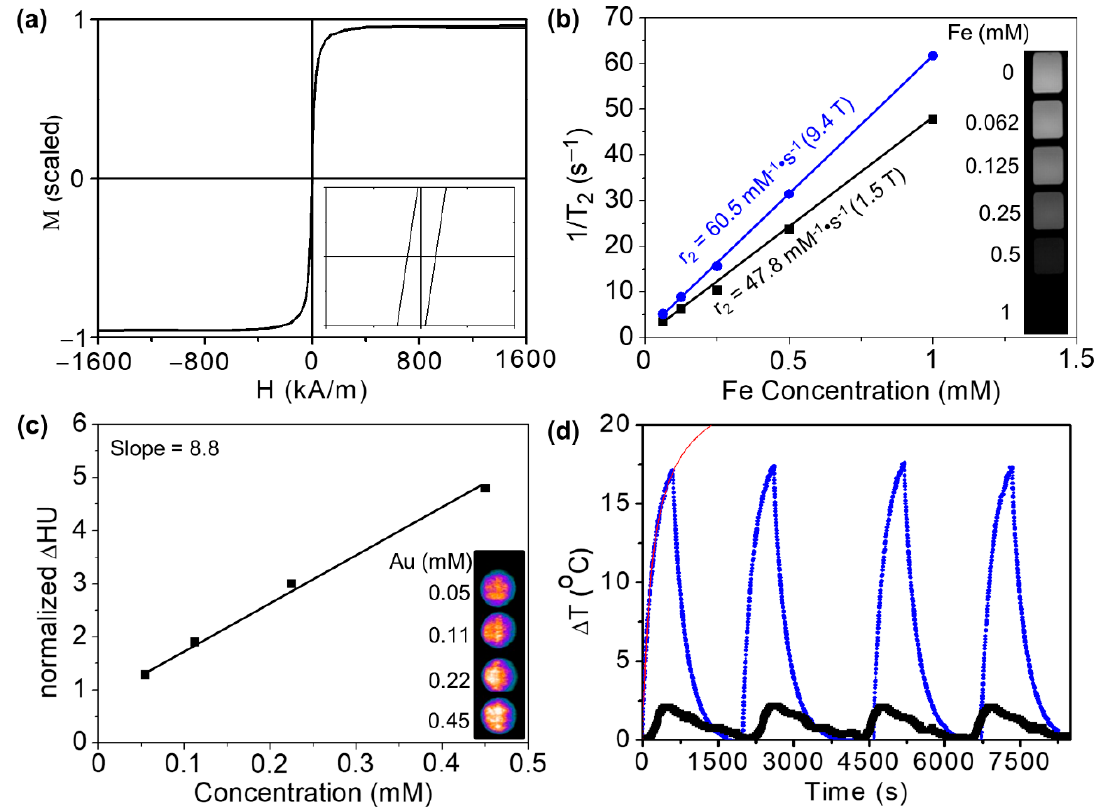
Figure 3. ( a ) Hysteresis loop of Au@Fe ‐ PEG NPs measured at 300 K scaled to the maximum magnetization value. ( b ) Plot of relaxation rate (1/T 2 ) vs. the concentration of Fe in the Au@Fe ‐ PEG NP suspension determined at 1.44 T (black dots) and 9.4 T (blue dots), and the linear fits (black and blue lines) whose slopes correspond to the transverse relaxivities (r 2 ) of Au@Fe ‐ PEG NPs at both magnetic fields. ( c ) X ‐ ray attenuation measured as the linear relationship between the normalized ∆ HU of the CT images and the Au concentration of the Au@Fe ‐ PEG NP solutions. ( d ) Thermal stability test of Au@Fe ‐ PEG NPs measured under NIR irradiation (blue) and AMF (black). The dashed red line is a fit to the solution of the Fourier transform of a point ‐ like source.